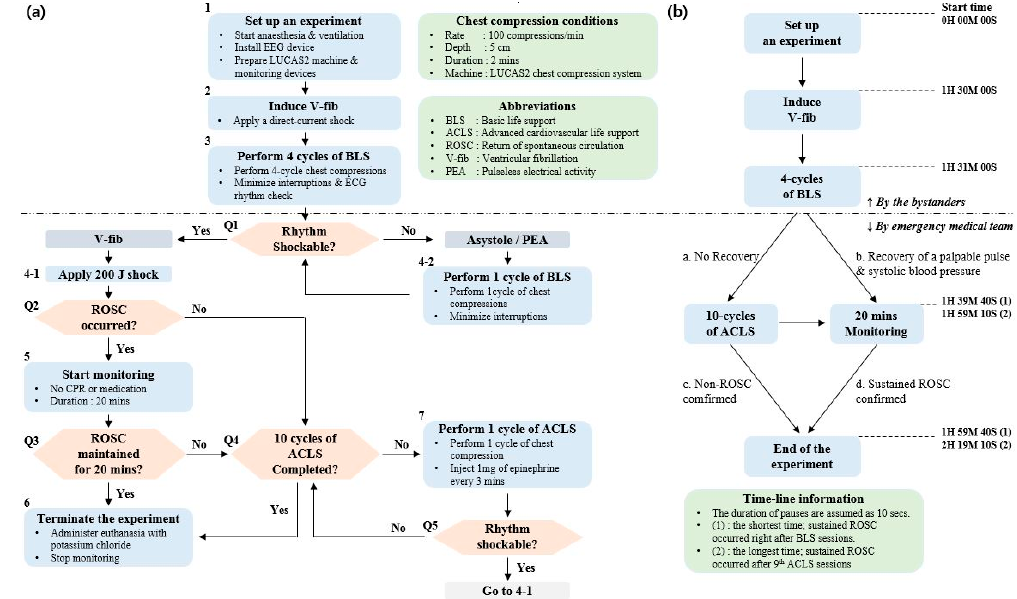
Figure 2. The entire test scenario: ( a ) flow chart from surgical procedure to basic life support (BLS), advanced cardiovascular life support (ACLS), and termination; ( b ) brief timeline of the test protocol.